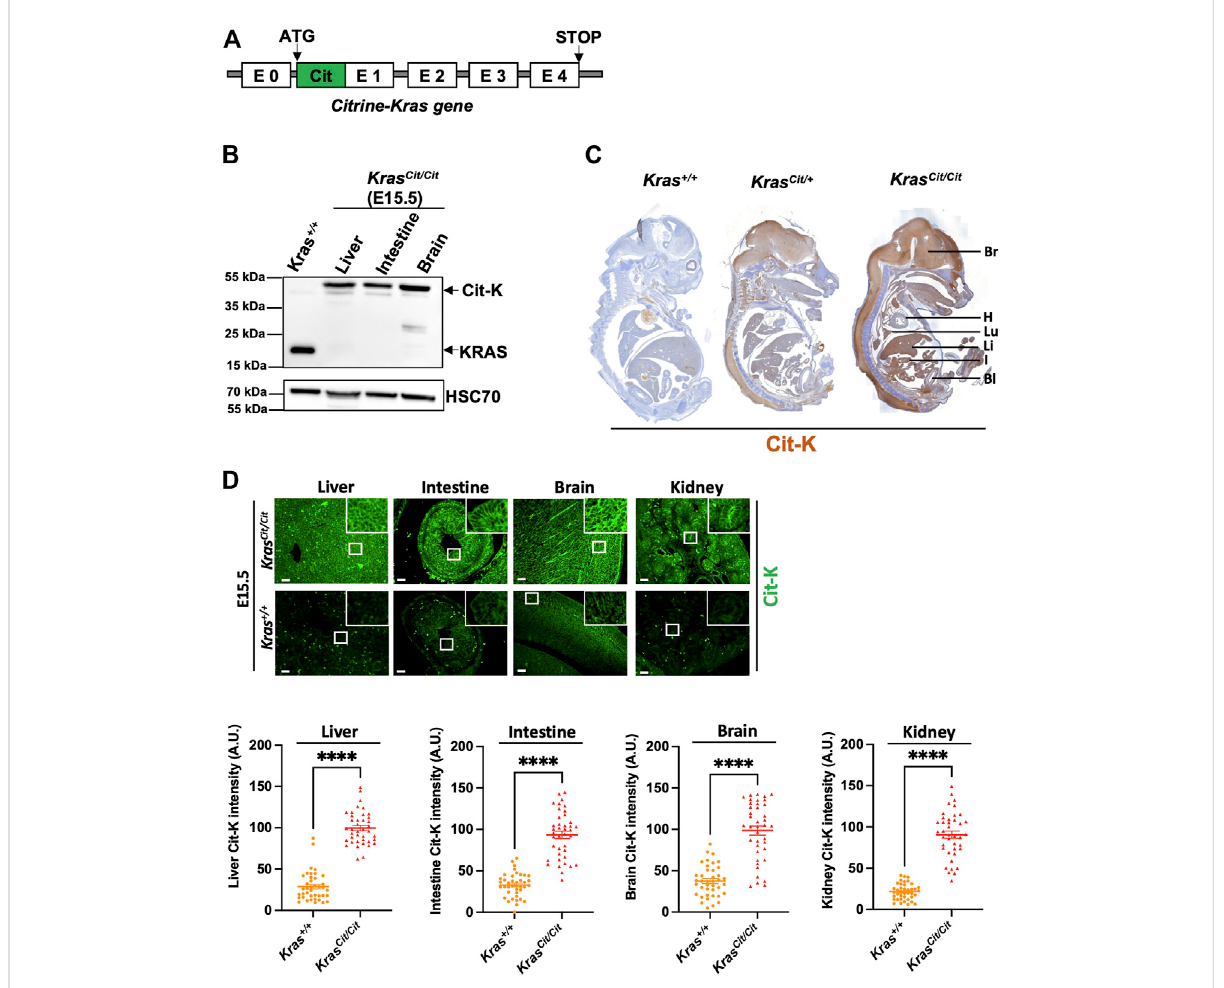
Citrine-KRAS(Cit-K)fusion proteinisexpressed inE15.5 Kras Cit/Cit embryos. (A) Constructionofthe Kras Cit/Cit mouse modelgenerationusingthe CRISPR/Cas9 technology. (B) Western blot on liver, intestine, and brain protein lysates of E15.5 Kras cit/cit embryos. A KRAS antibody has been used to detect both KRAS and Cit-K. Heat shock cognate protein 70 (HSC70) has been used as loading control. W ild-type KRAS is detected to ~22 kDa and Citrine-KRASisdetectedto~48 kDa,asexpected.The Kras +/+ linecorrespondstoaproteinextractfromcellsexpressing wild-typeKras toshow wild-type KRASattheexpectedsizeof~22 kDa. (C) ImmunohistochemistryusingaGFPantibody(brown)onawholesectionofE15.5 Kras +/+ , Kras cit/+ and Kras Cit/Cit embryos counterstained with hematoxylin (blue). As expected, weak background was observed on the Kras +/+ embryo, while the staining was most intense on the Kras Cit/Cit embryo. Bl, bladder; Br, brain; H, heart; I, intestine; Li, liver; Lu, lung. (D) Cit-K immunolabeling on E15.5organsectionsof Kras +/+ and Kras Cit/Cit embryos.Withtheexceptionofintensenon-speci fi clabeling intissue-residentredbloodcells, noCit-K labeling isobserved in Kras +/+ embryos.Graphs representCit-KintensitymeasuredbyFIJI software.Onedot representsthemeanofthreemeasures of signal intensity on one cell. Data are represented as mean+/-SEM of 40 cells ( n = 4 mice). Statistical signi fi cance was tested by Student ’ s t -test. ****, p < 0.0001. A.U. arbitrary